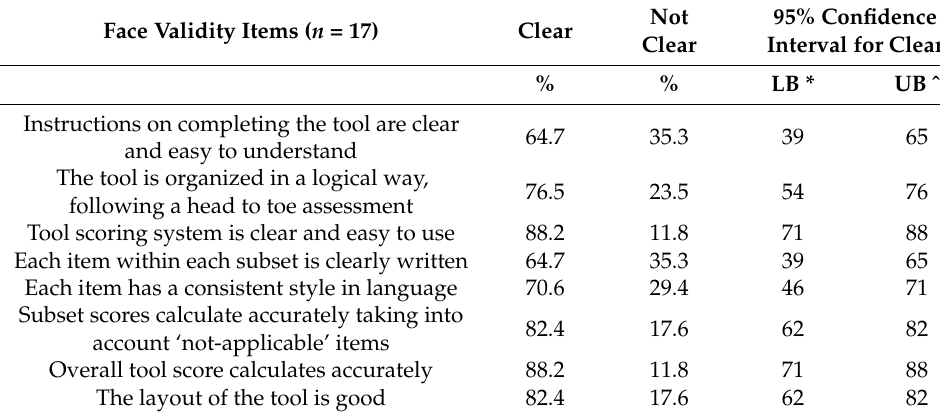
Table 2. Face Validity Rating of the